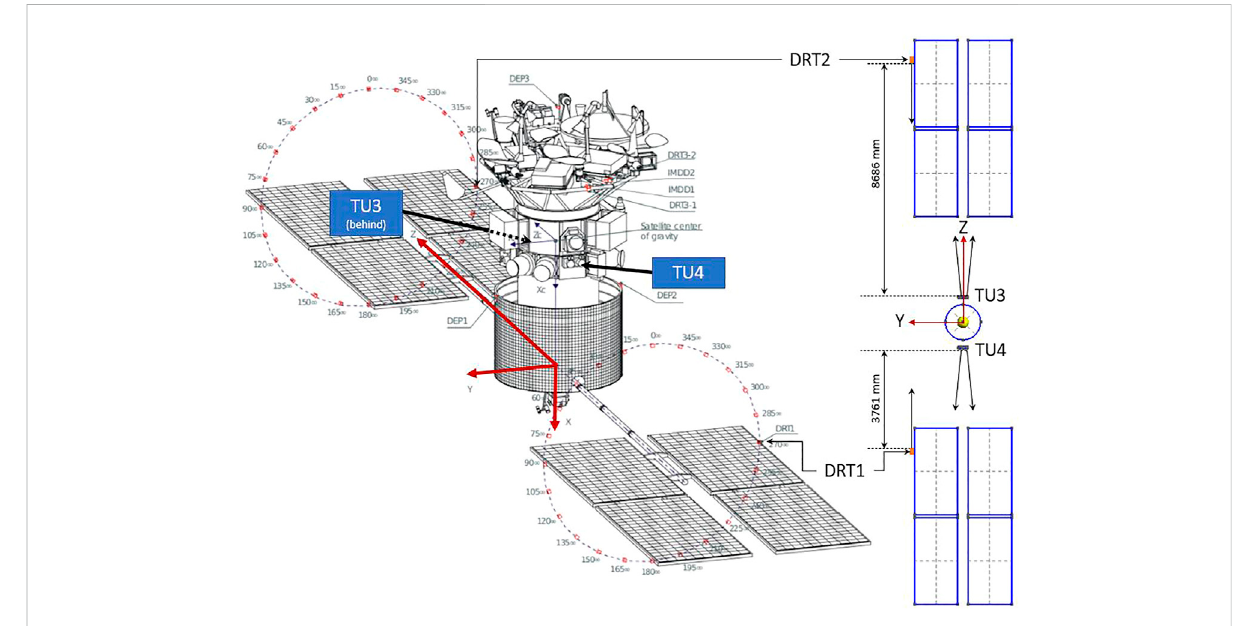
FIGURE 1 Express-A thruster and RPA locations